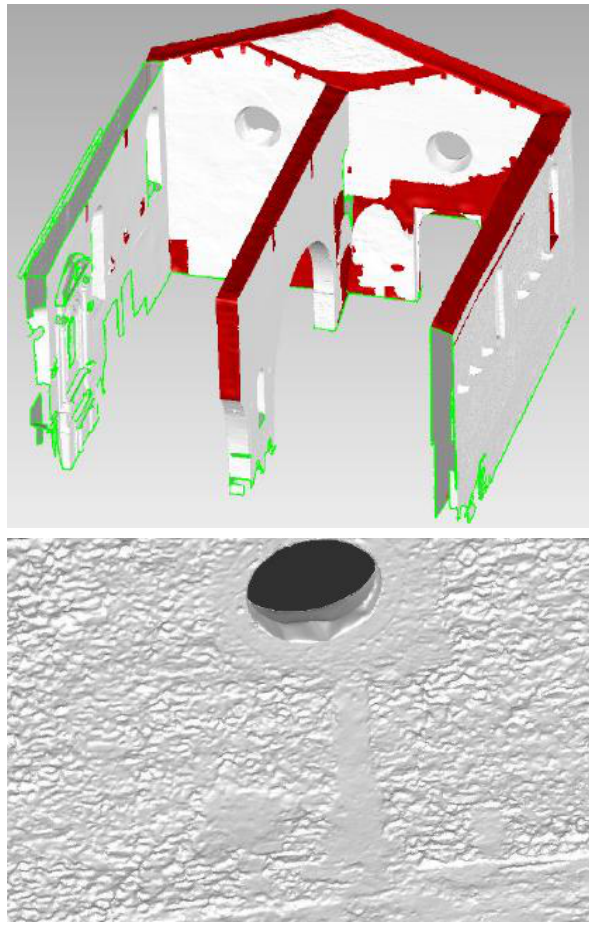
Figure 9 . Modeling phases of the 3D poly-face mesh results of the structural complex from the integrated database.